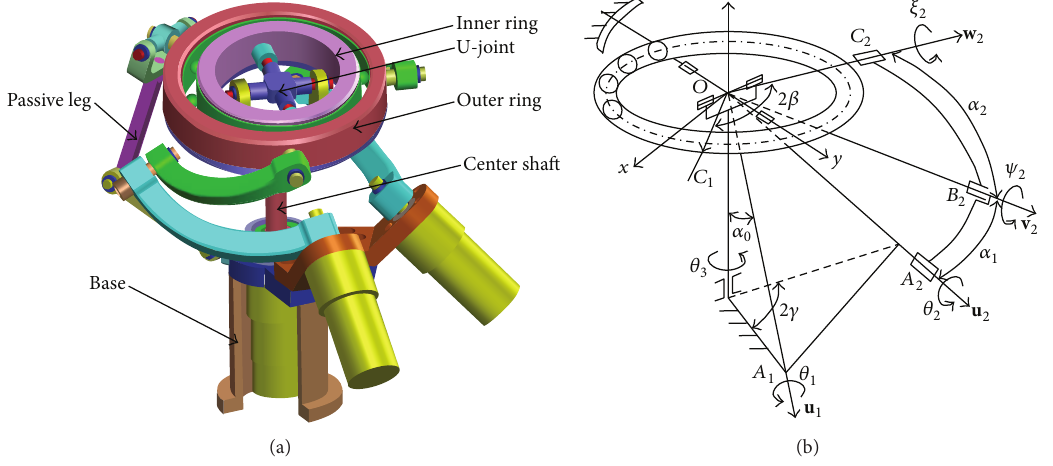
Figure 1: The asymmetrical spherical parallel manipulator: (a) CAD model; (b) coordinate